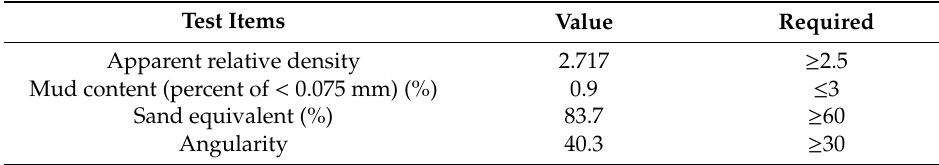
Table 3. Physical Properties of Fine Aggregates.